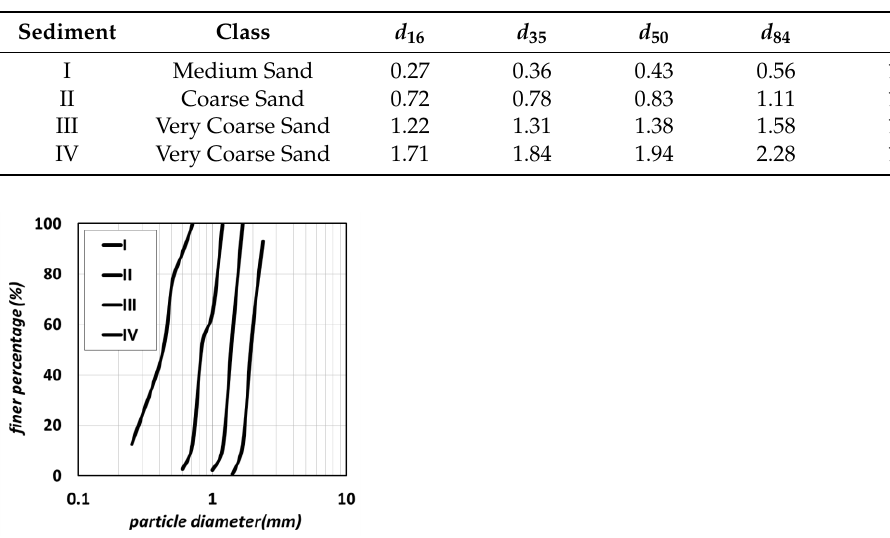
Table 1. Grain size characteristics of four groups of screened and graded sediments—mm.